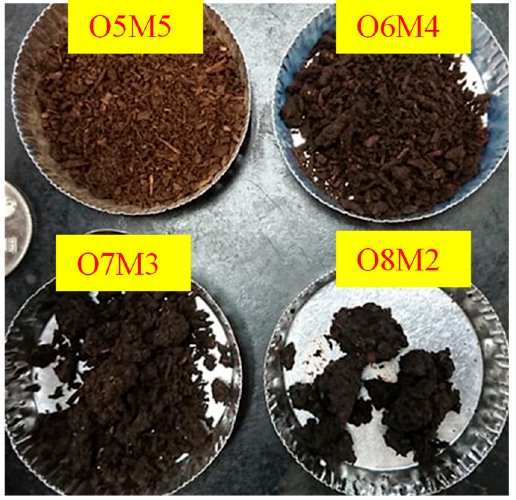
Figure 2. Appearances of